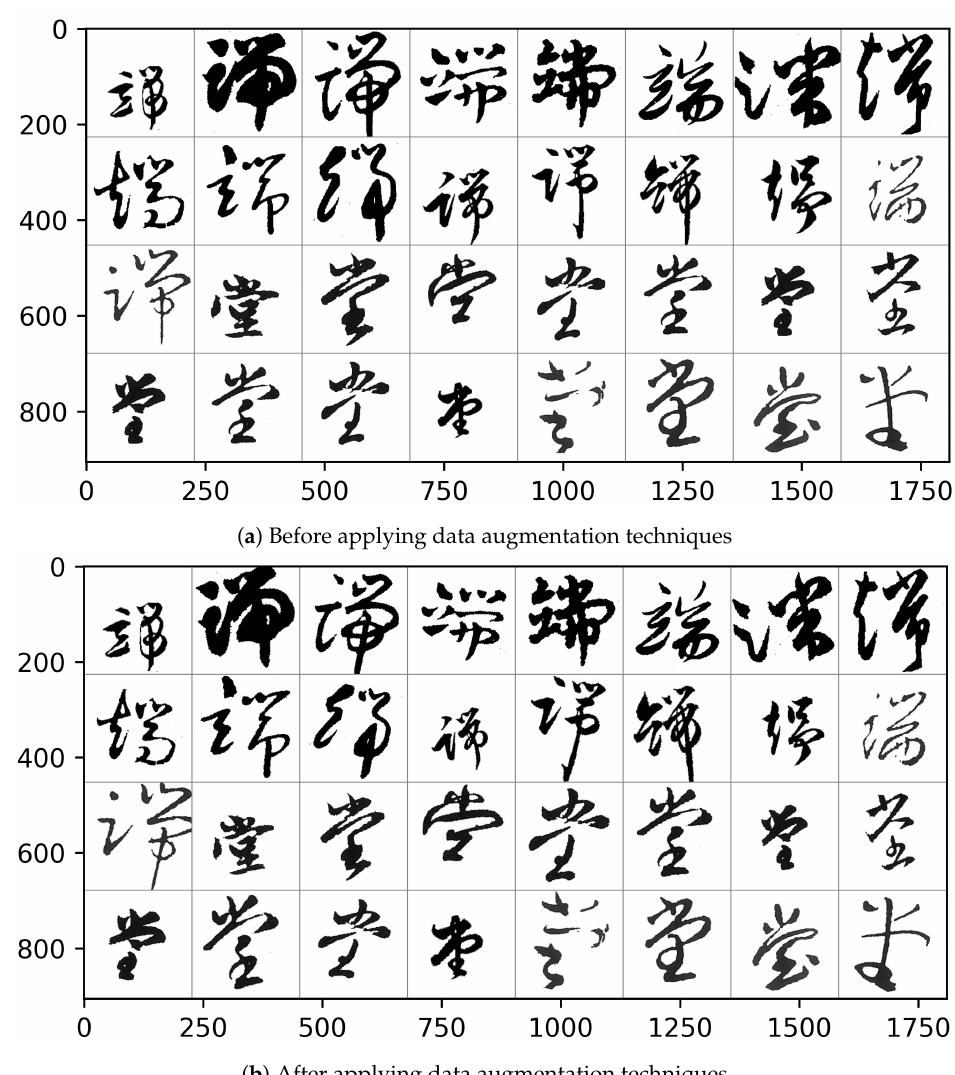
Figure 3. An example image of data augmentation